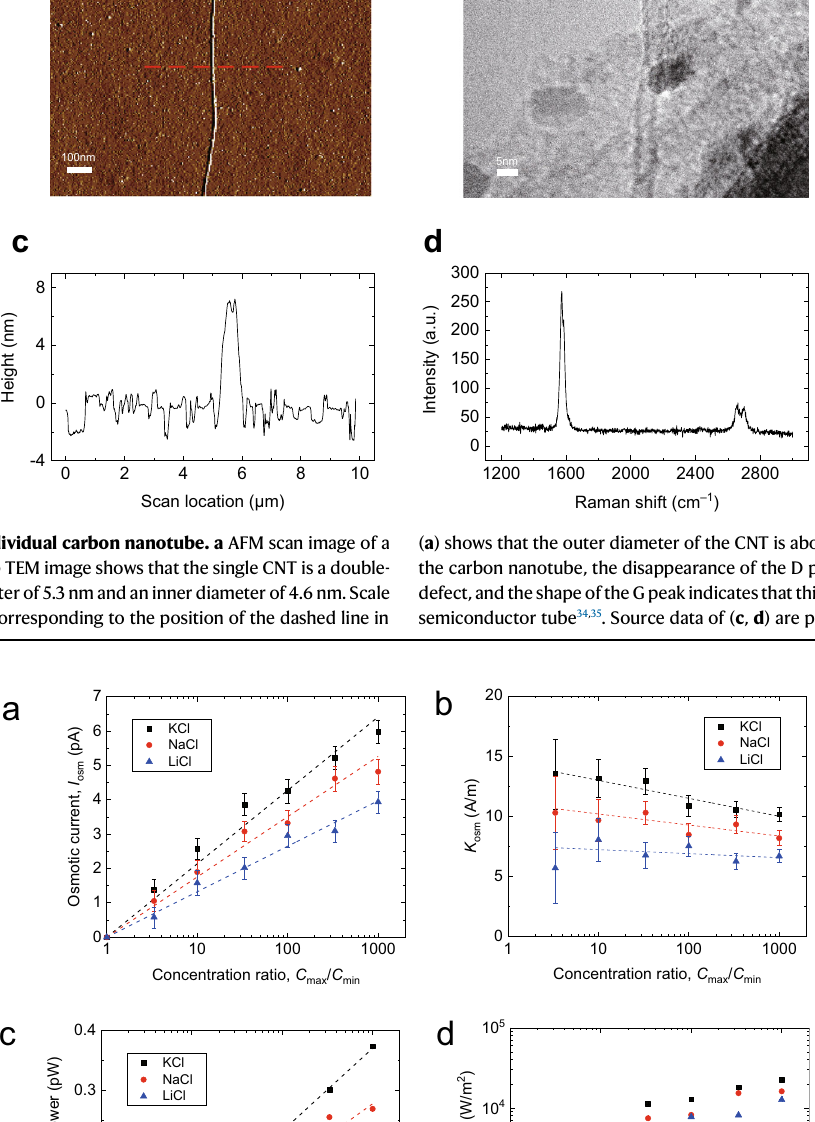
threekindsofsolutionsasafunctionoftheconcentrationratio. c , d Corresponding produced osmotic net power ( c ) and single-pore power density ( d ) versus the concentrationratio.Thedashedlinesareusedtoguidetheeyes.Sourcedataofthis fi gure are provided as a Source Data fi